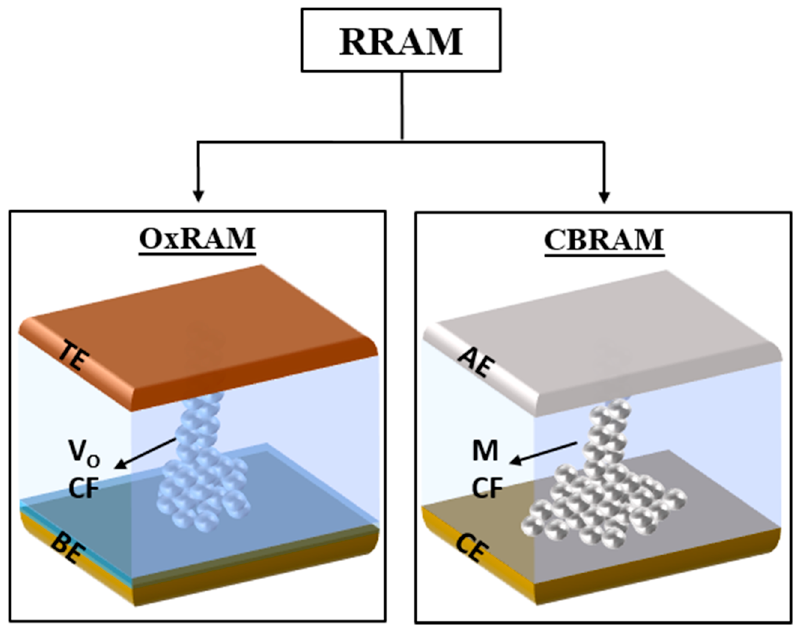
Figure 1. A schematic representation of the classification of RRAM on the basis of switching mech- anisms as: OxRAM and CBRAM. nisms as: OxRAM and